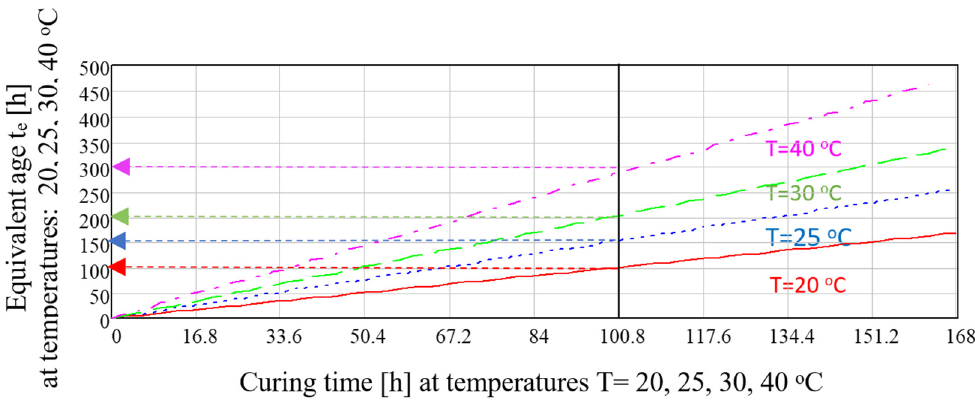
Figure 7. Equivalent age t e for CEM I 52.5 R ( E n = 41.9) and different curing temperatures.